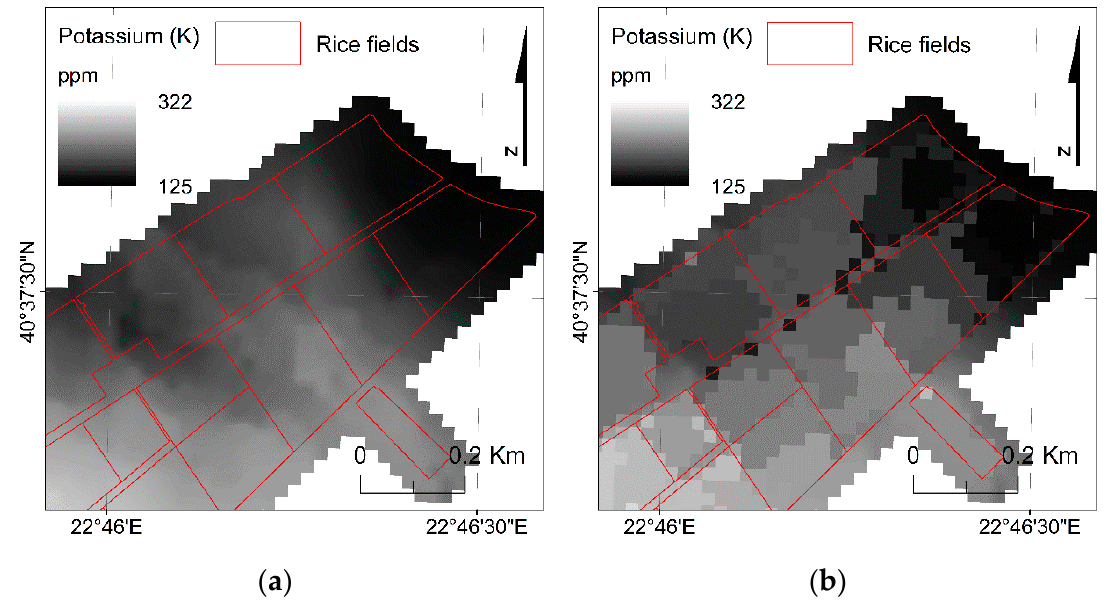
Figure 11. An indicative example of soil surface upscaling: ( a ) The original potassium (K) surface in a part of the farm; ( b ) the corresponding layer of the potassium mean per management zone.